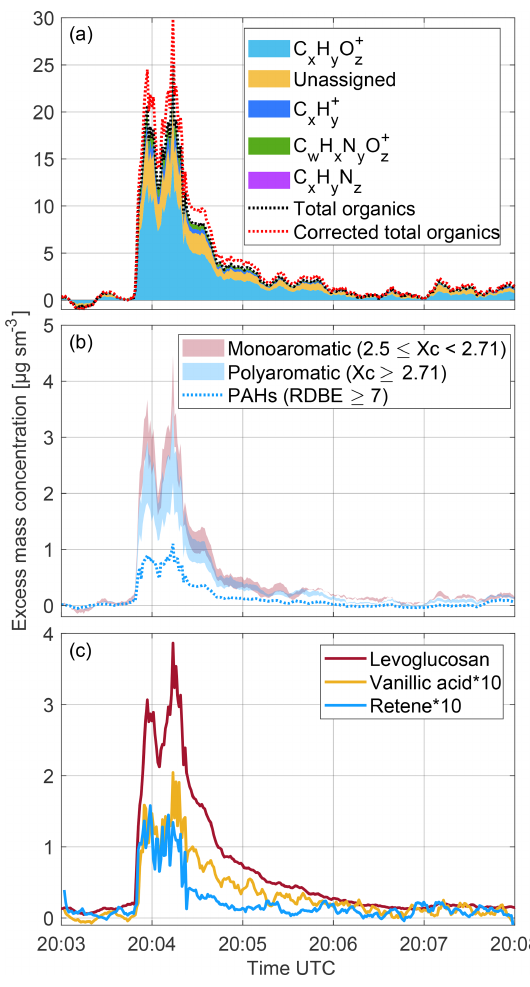
Figure 2. The 1Hz time series of excess mass concentrations of (a) total uncorrected organics and total fragmentation-corrected or- ganics as well as CH, CHO, CHN and CHNO compound classes; (b) monoaromatic and polyaromatic compounds together with PAHs (Sect. 2.5 should be consulted for details and limitations) and (c) levoglucosan, vanillic acid and retene as measured by the CHARON PTR-ToF-MS instrument during a wildfire plume pene- tration over the Sierra Nevada in California. A 10s moving-average filter has been applied to data outside the